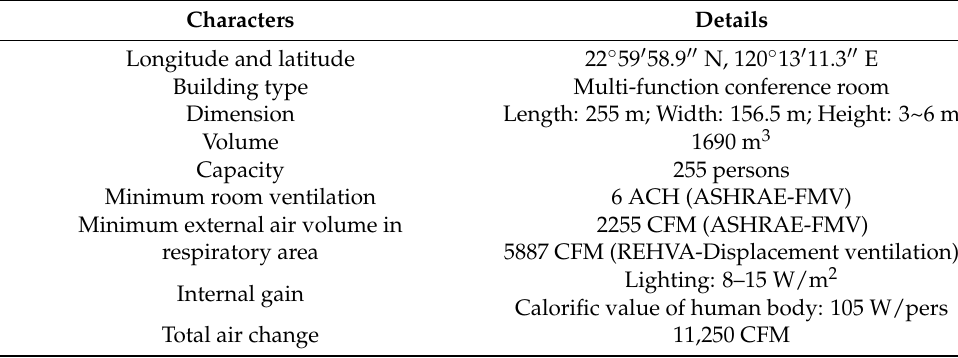
Figure 1. The site photo and plan of the case building. Table 1. Detailed information on the case building.